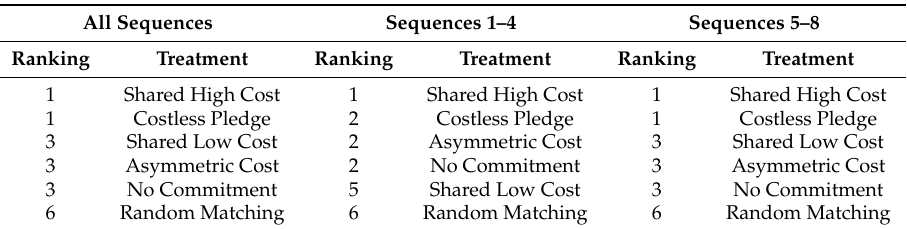
Table 3. Treatment efficiency